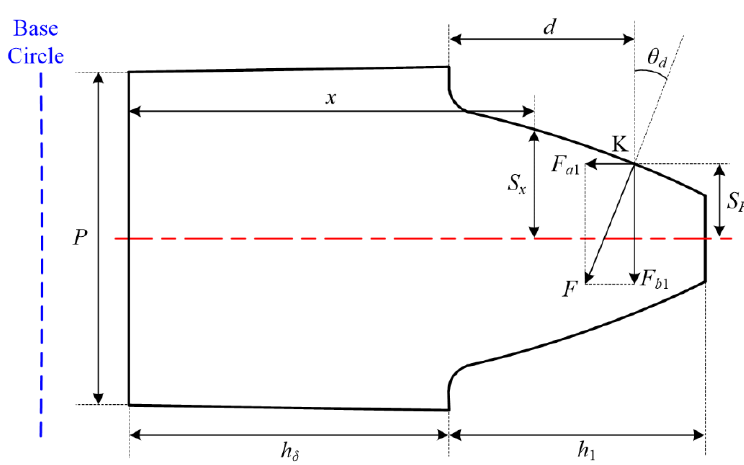
Figure 9. Single-tooth beam model of the involute flexible wheel.